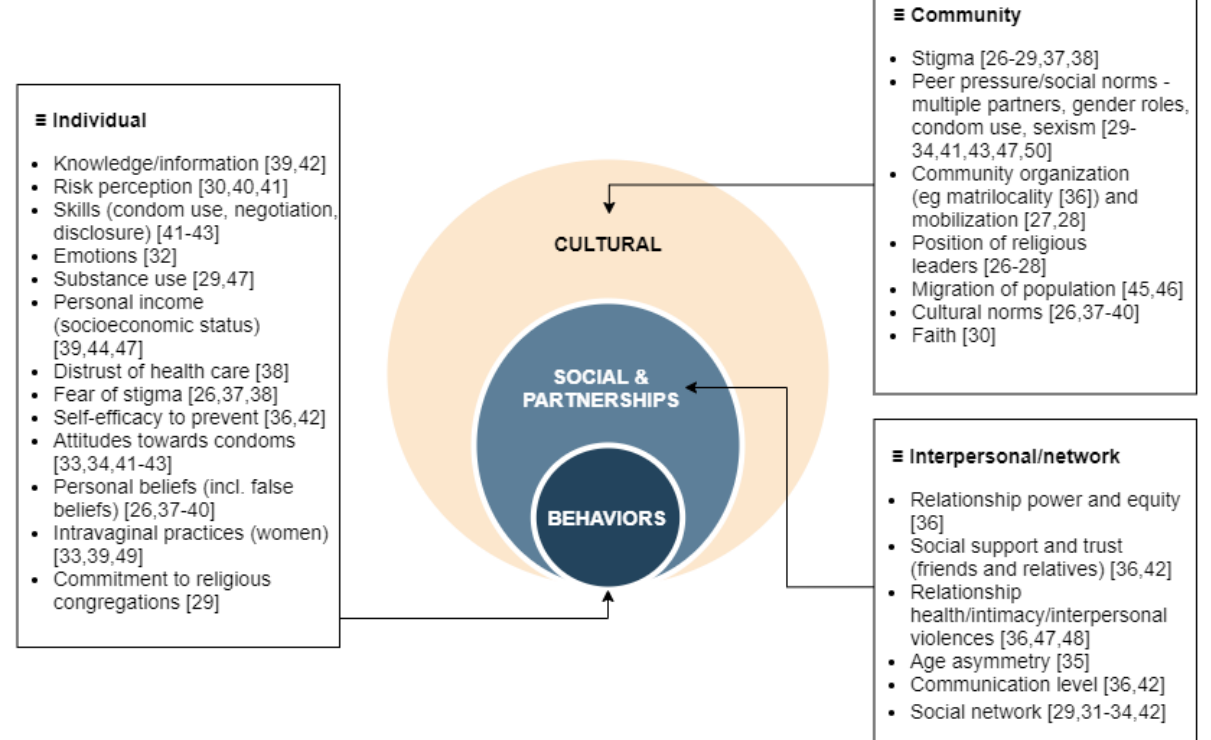
Figure 3. Summary of factors found within publications identified by the